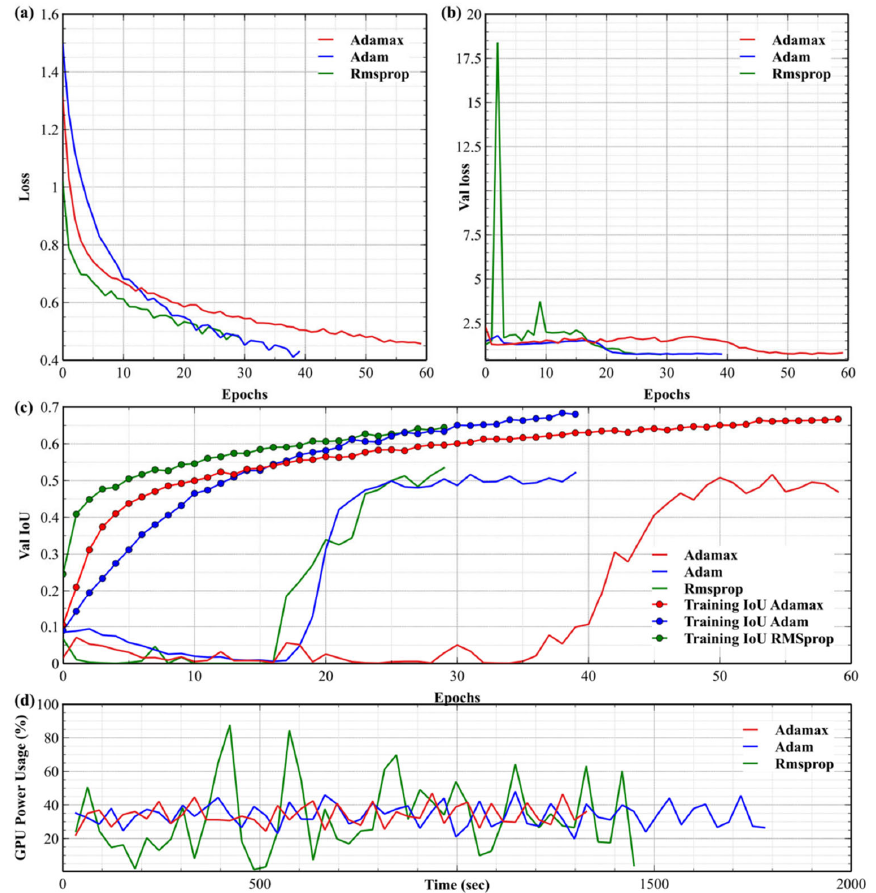
Figure 10 . Evolution of training metrics for the three best optimizer configurations: ( a ) training loss function evolution; ( b ) validation loss during training; ( c ) training and validation IoU segmentation metrics; ( d ) GPU power consumption during training.